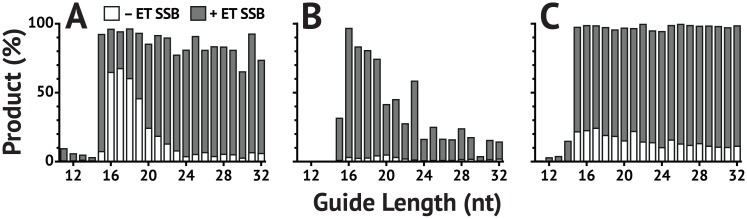
ET SSB enables the use of longer 5′-phosphorylated guides.TtAgo can utilize 5′-phosphorylated guides of varying length, the most active falling in the range of 16–19 nt in the absence of ET SSB. (A–C) show percent product, determined by CE, after 1 hr at 73 °C either with 1.2 μM ET SSB (dark grey) or without ET SSB (white). (A) TtAgo with a single guide and ssDNA substrate; (B) TtAgo with a single guide and dsDNA substrate; (C) Pf Ago with a single guide and ssDNA substrate.